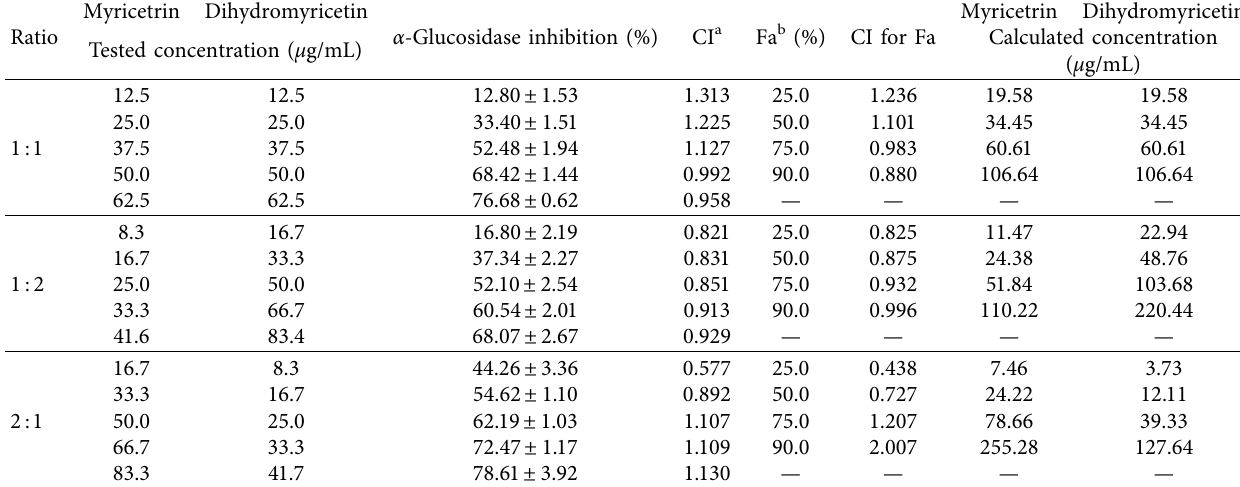
Table 1: Interaction between myricetrin and dihydromyricetin on α -glucosidase inhibition. Ratio